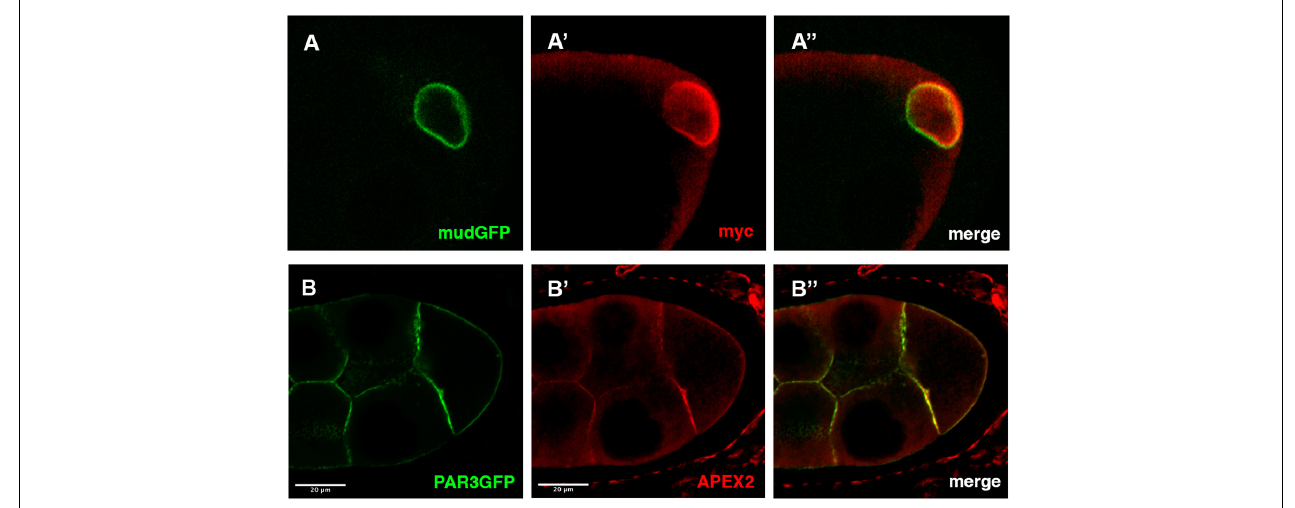
FIGURE 2 | Detection APEX2-GFP protein by immunofluorescence. (A,B) In mud-GFP ; mat-Tub-Gal4 VP 16 , UAS-mycAPEX2-GBP ovarian follicle, the GFP signal is detected around the nucleus of the oocyte (A) . With anti-myc antibodies (A’) , we observe a similar pattern that overlaps with the GFP fluorescence (A”) . Similarly, in nos-Gal4 VP 16 , UAS-APEX2-GBP , UAS-Par3-GFP egg chamber, we observe the GFP (B) associated with the membranes. Anti-APEX antibodies (B’) reveal an overlapping staining (B”)